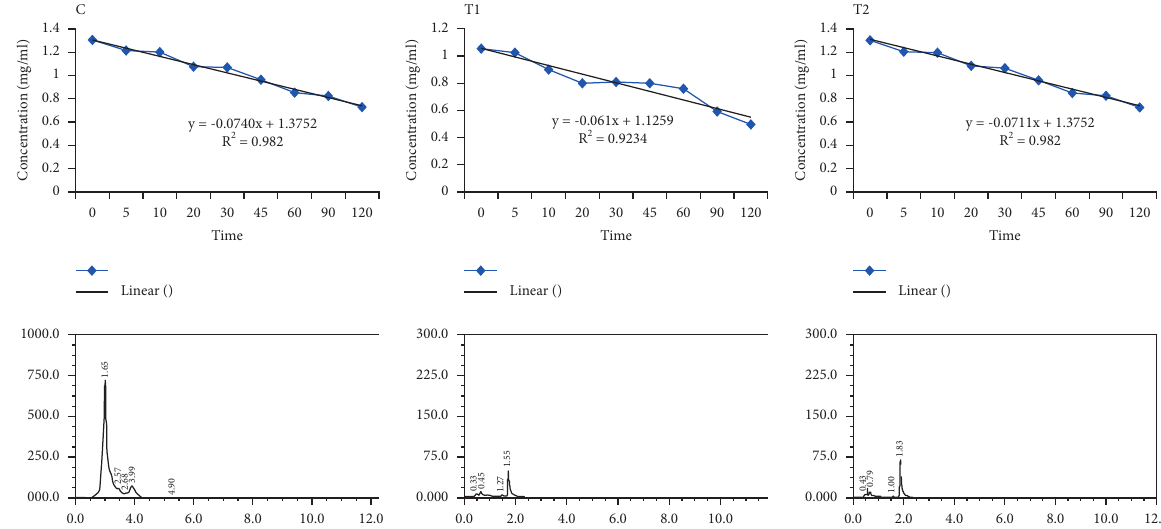
Figure 4: Changes in thiopental concentrations in studied groups by HPLC method. Table 4: Changes in body weight and thiopental pharmacokinetic parameters in the studied groups.